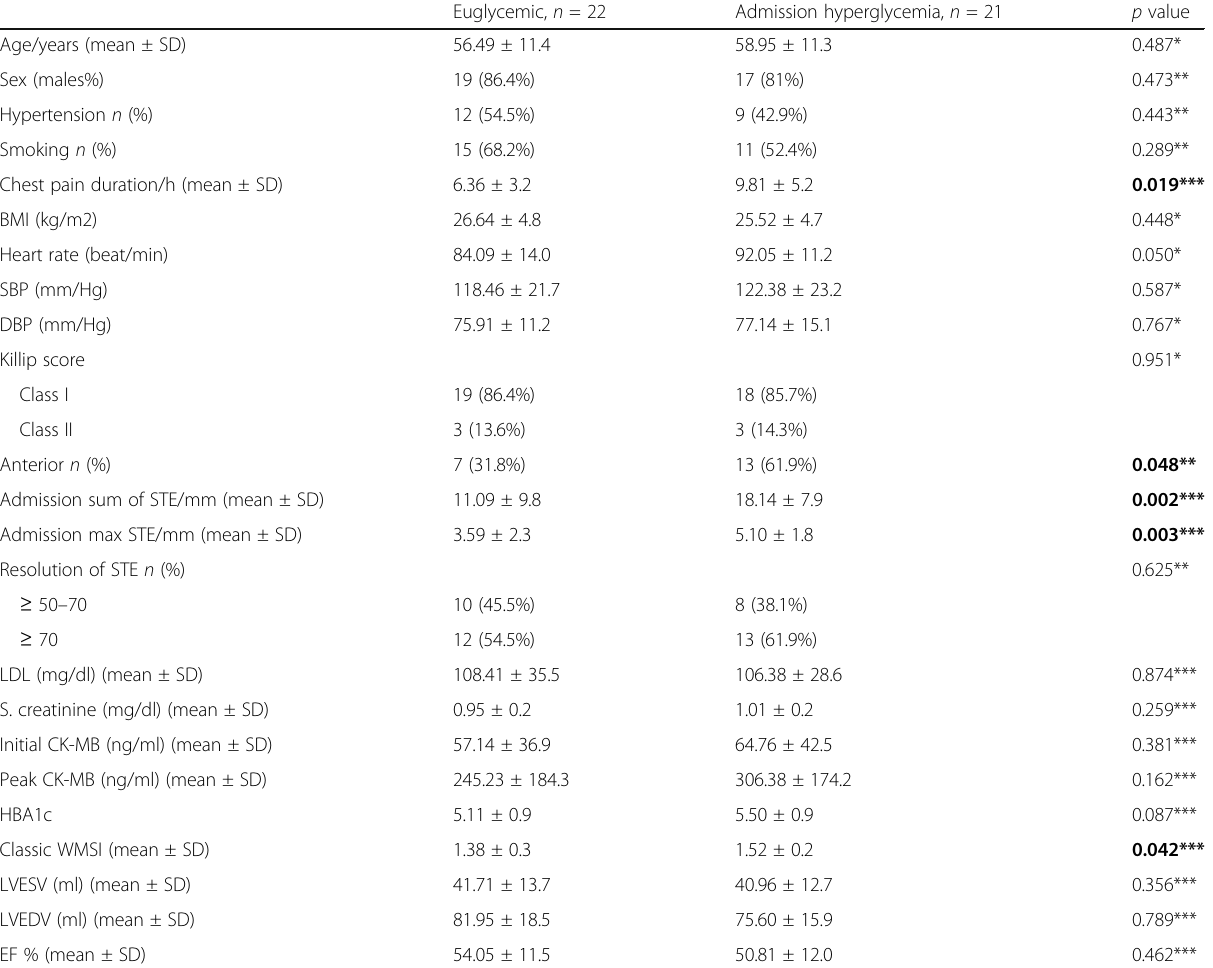
Table 1 Patients ’ clinical and echocardiographic